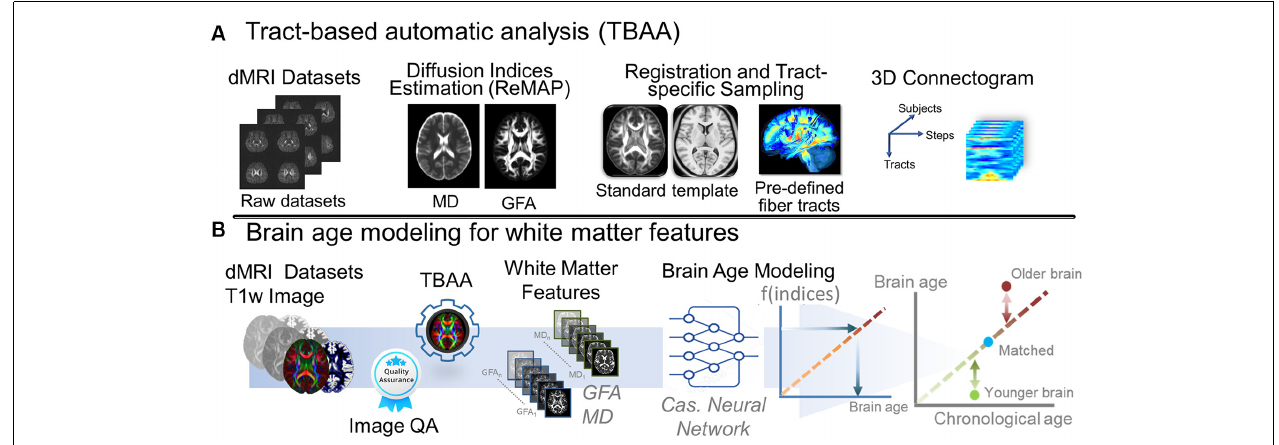
FIGURE 2 | Analytic pipeline of diffusion MRI reconstruction and the corresponding brain age modeling for white matter features. (A) The pipeline depicts the pipeline of TBAA. (B) The pipeline displays the brain age modeling for WM. Abbreviation: dMRI, diffusion magnetic resonance imaging; MD, mean diffusivity; GFA, generalized fractional anisotropy; QA, quality assurance; Cas, cascade; ReMAP, regularized mean apparent propagator reconstruction.